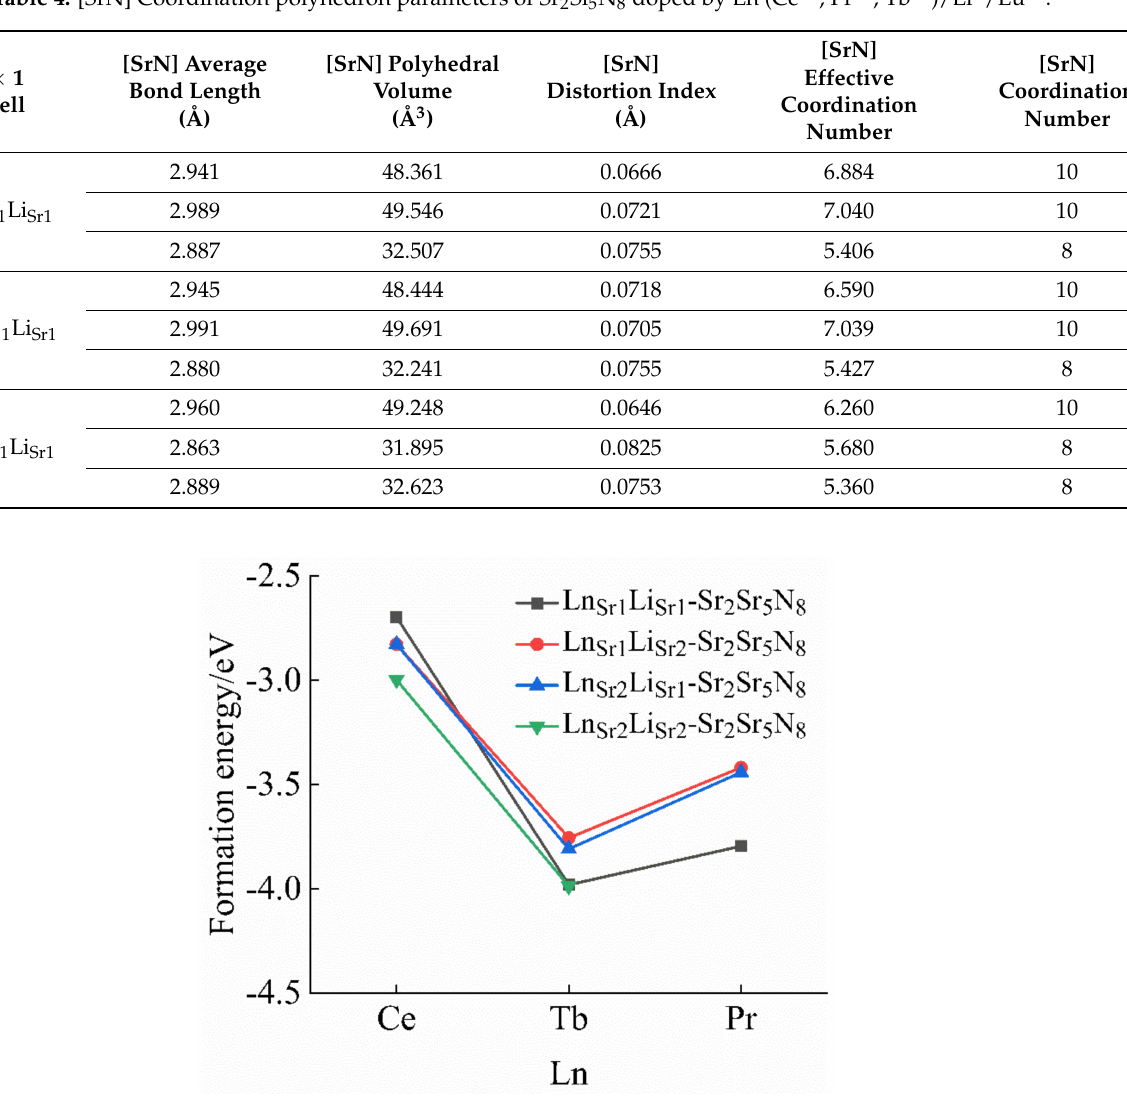
Table 4. [SrN] Coordination polyhedron parameters of Sr 2 Si 5 N 8 doped by Ln (Ce 3+ , Pr 3+ , Tb 3+ )/Li + /Eu 2+ .